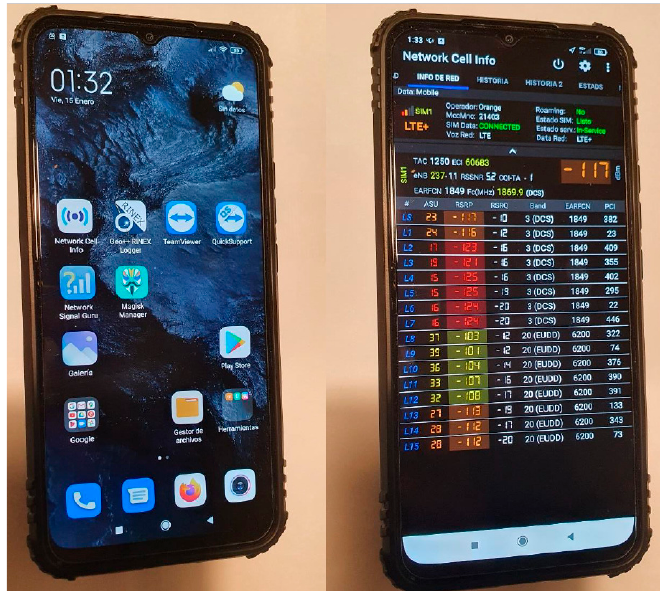
Figure 6. Xiaomi mi 10 lite ( left ) running the Network Cell Info program ( right ) .